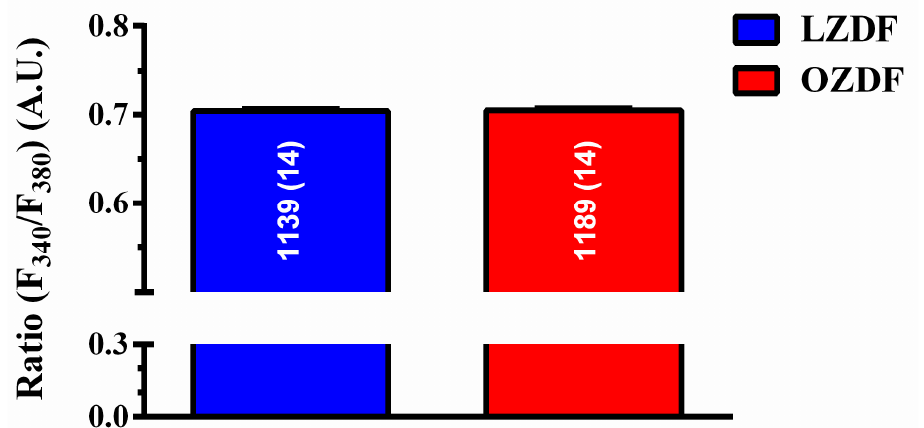
Figure 2. Resting [Ca 2 + ] i is not altered in native aortic endothelium of obese Zucker diabetic fatty rats. Ratiometric measurement (Ratio F340 / F380) of resting Fura-2 fluorescence revealed that basal Ca 2 + levels, expressed as mean ± SE, were not significantly di ff erent in OZDF as compared to LZDF rats. A.U. (arbitrary units).